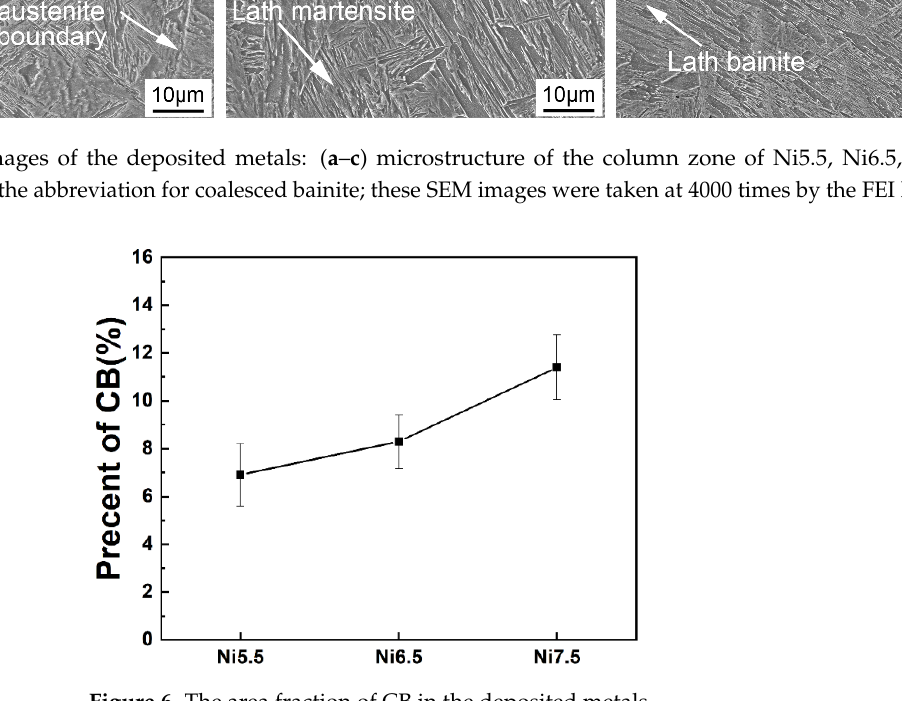
Figure 5. SEM images of the deposited metals: ( a – c ) microstructure of the column zone of Ni5.5, Ni6.5, and Ni7.5, respectively; CB is the abbreviation for coalesced bainite; these SEM images were taken at 4000 times by the FEI Inspect F50.